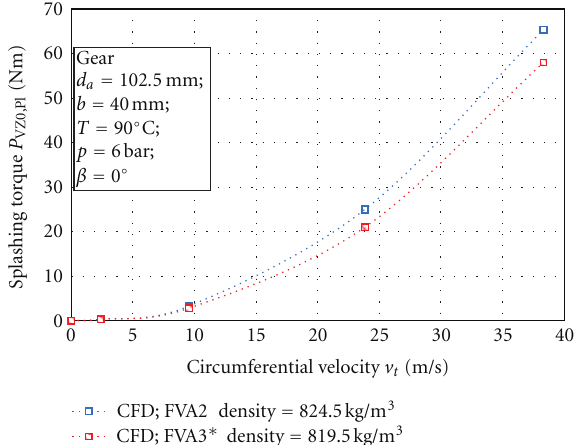
Figure 15: Results in terms of resistant torque versus circumferen- tial velocity—Influence of the lubricant